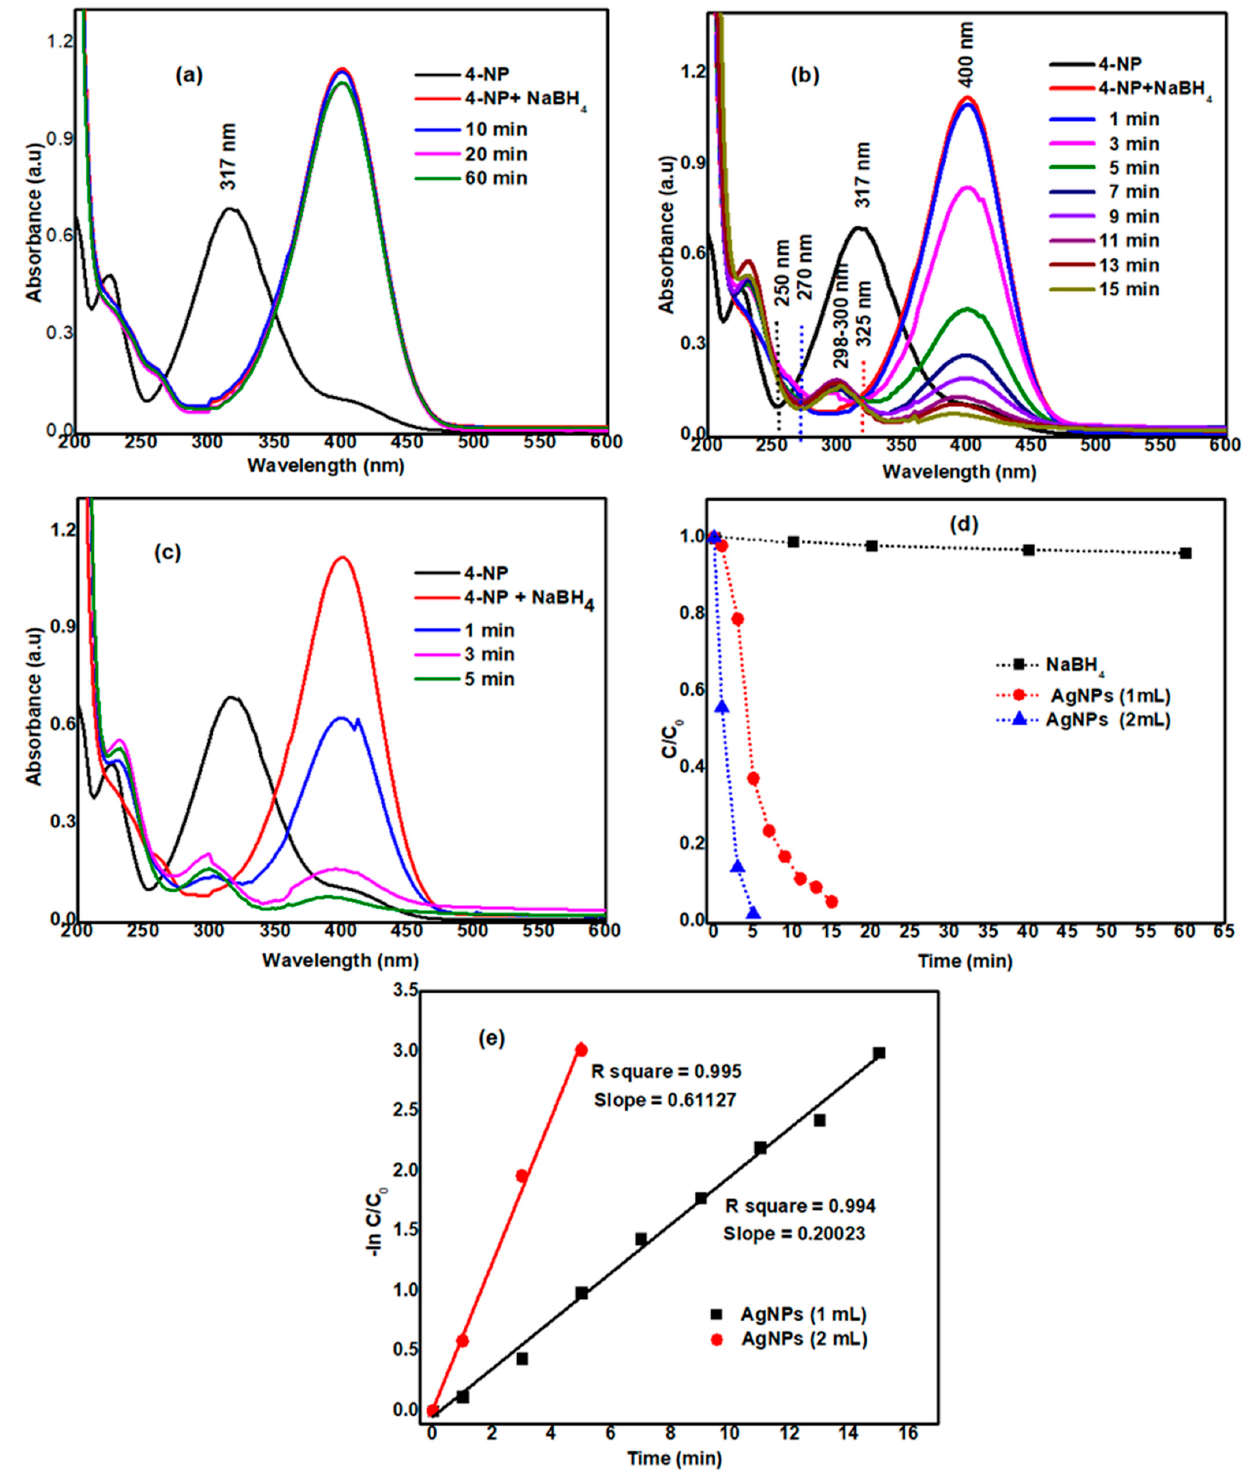
Figure 14. ( a ) Catalytic reduction of 4NP by ( a ) NaBH 4 , ( b ) 1 mL AgNPs, ( c ) 2 mL AgNPs, ( d ) C/C 0 and ( e ) -ln C/C 0 vs.